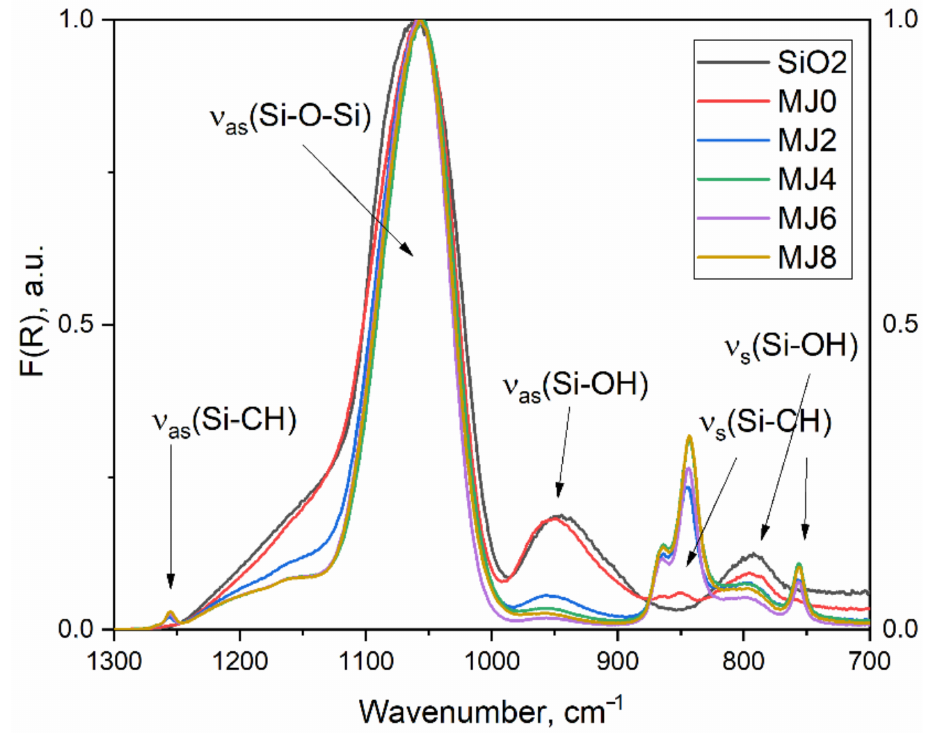
Figure 1. Normalized ATR-IR spectra of the studied samples. Sample notations are the same as in Table 1: MJ0— α = 0; MJ2— α = 0.352; MJ4— α = 0.700; MJ6— α = 1.055 and MJ8— α = 1.407. The SiO 2 represents bulk